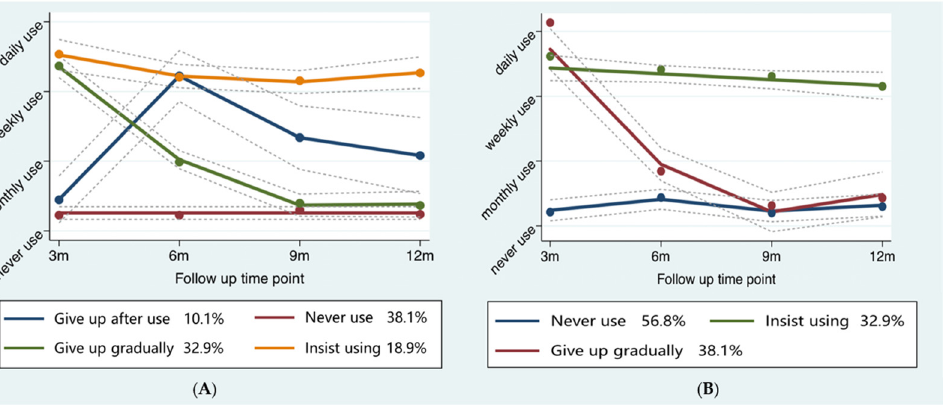
Figure 3. Trajectory analysis of food management tools usage patterns. ( A ) Food guiding booklet usage; ( B ) Dinner set usage.